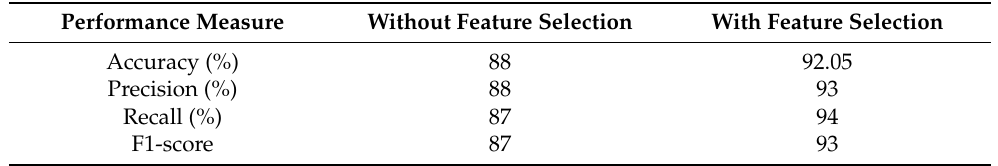
Table 7. Evaluation of the LSTM+CNN model’s performance with and without feature selection with feature selection.